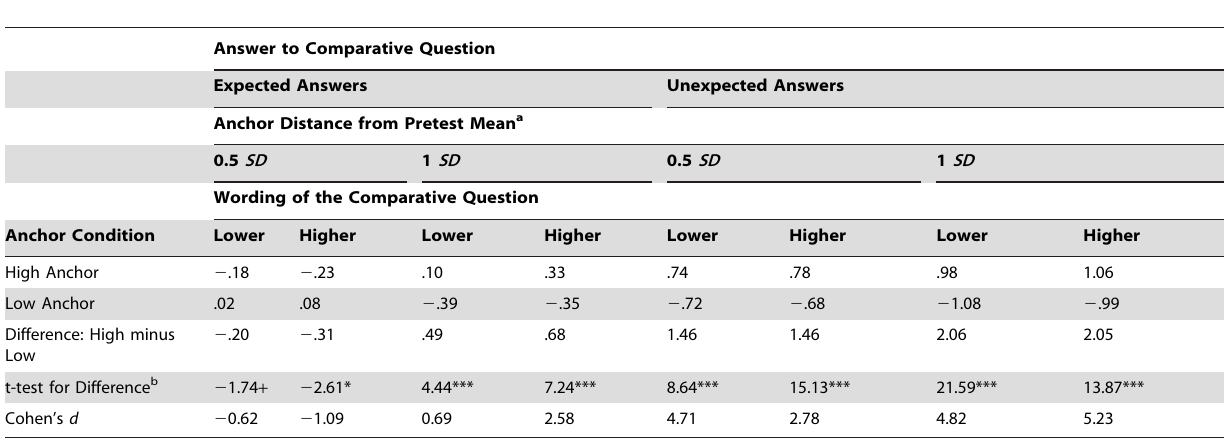
Table 3. Estimates by wording, anchor condition, and answer to comparative question (Study